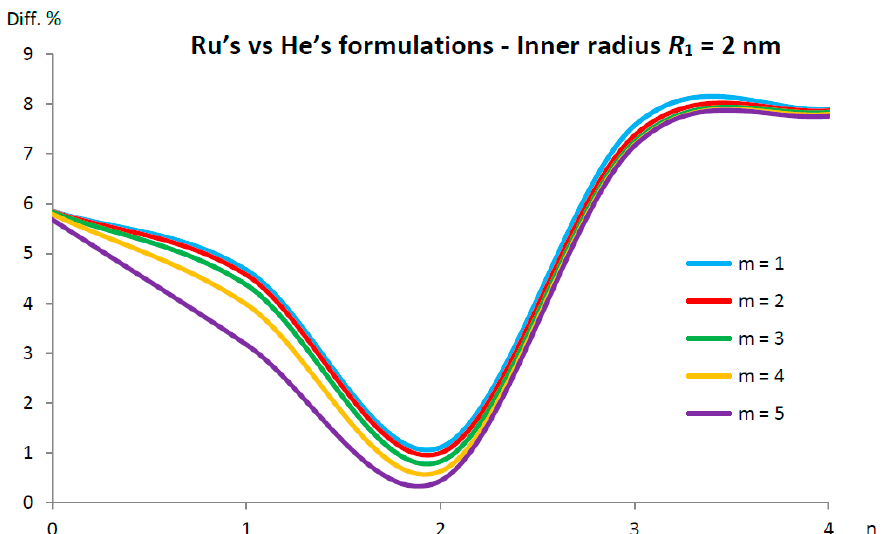
Figure 6. Percentage differences between the highest radial natural frequencies of the simply sup- ported DWCNT of Table 1 with inner radius R 1 = 2 nm and aspect ratio L / R 2 = 10 from Ru’s (38) and He’s (39) formulations. Donnell shell theory. Anisotropic elastic shell model. Number of longitudinal half-waves m . Number of circumferential waves n.